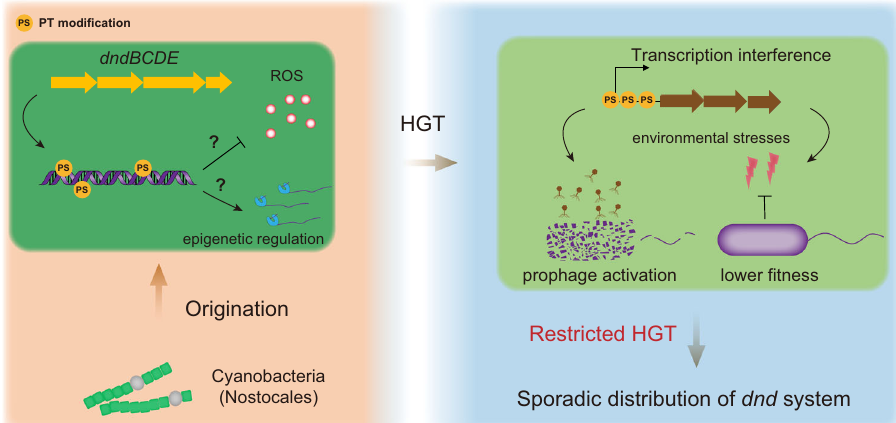
Fig. 7 Schematic representation of the hypothetical evolutionary scenario of the dnd system. The dnd system with a primordial con fi guration originated in ancient Cyanobacteria (probably Nostocales). The original dnd system is thought to have dealt with the emergence of reactive oxygen species (ROS) after the GOE. Alternatively, it may evolve fi rst as an epigenetic system for gene regulation. The decreased fi tness (including induction of inherent prophages and a weakened ability to respond to environmental stresses) resulting from transcription interference by PT modi fi cation would subsequently lead to a substantial restriction of HGT of the dnd system between microorganisms, thereby causing their sporadic distribution in present